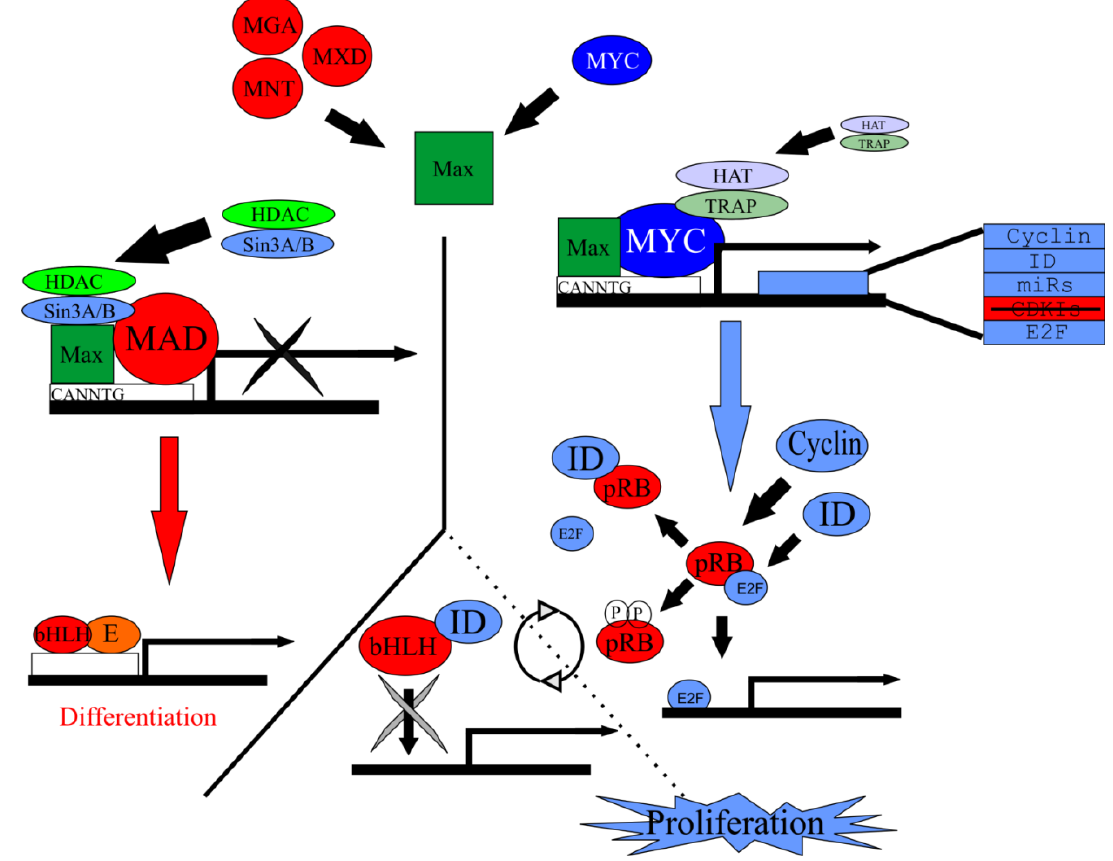
Figure 5. Myc/Max/Mad network regulates proliferation. Max forms a heterodimer with Myc but is also capable of forming a heterodimer with the Mad family of antagonists. Either heterodimer will bind to the CACGTG E-box sequence on target genes. Along with accessory binding partners, Myc/Max will allow for the transcription of target genes responsible for to proliferation. Contrarily, Mad/Max will inhibit the transcription of these target genes, leading ultimately to differentiation. Target genes of Myc / Max include cyclin , ID , E2F , and various microRNAs. Both the cyclins and IDs remove pRb from E2F and allow E2F to bind to S-phase promoting genes and allow subsequent proliferation. IDs are able to bind bHLH TFs but since they lack a basic motif, are unable to bind E-boxes, inhibiting differentiation. In the absence of IDs or cyclins, bHLH TFs are free to bind to E-proteins and the E-box, promoting differentiation. Modified from